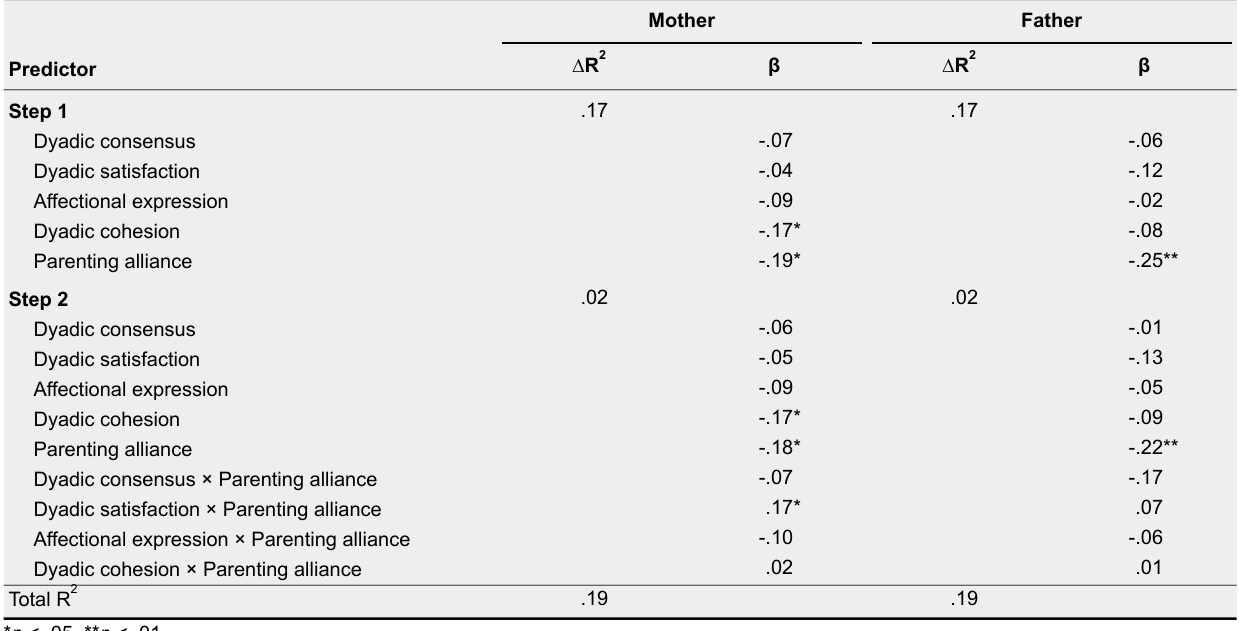
Hierarchical Regression Analysis Predicting Parenting Stress in Mothers (N = 236) and Fathers (N =